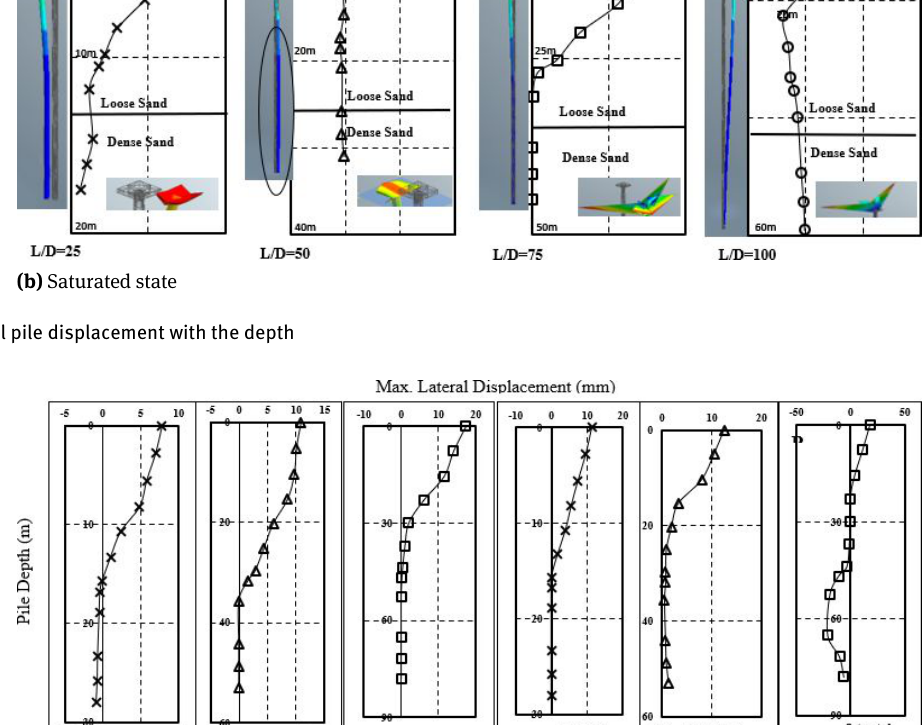
Figure 4: Lateral pile displacement with the depth (D pile = 1